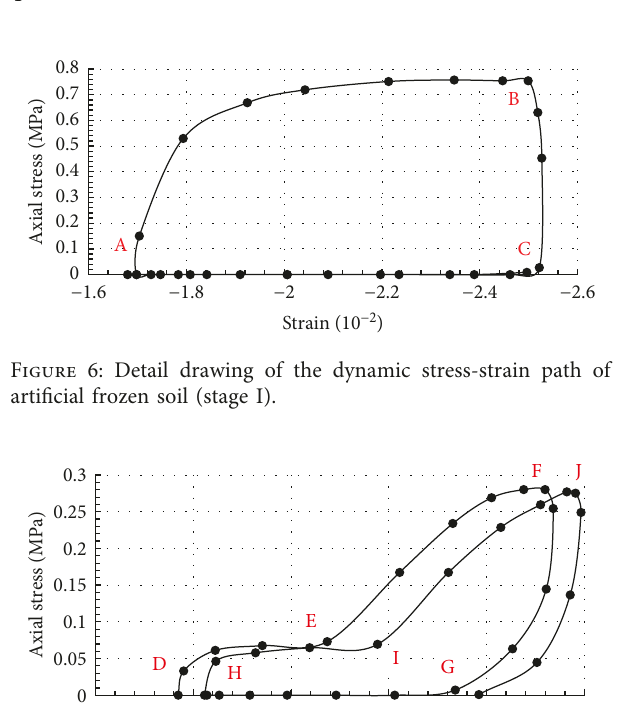
Figure 7: Detail drawing of the dynamic stress-strain of artificial frozen soil (stage III).